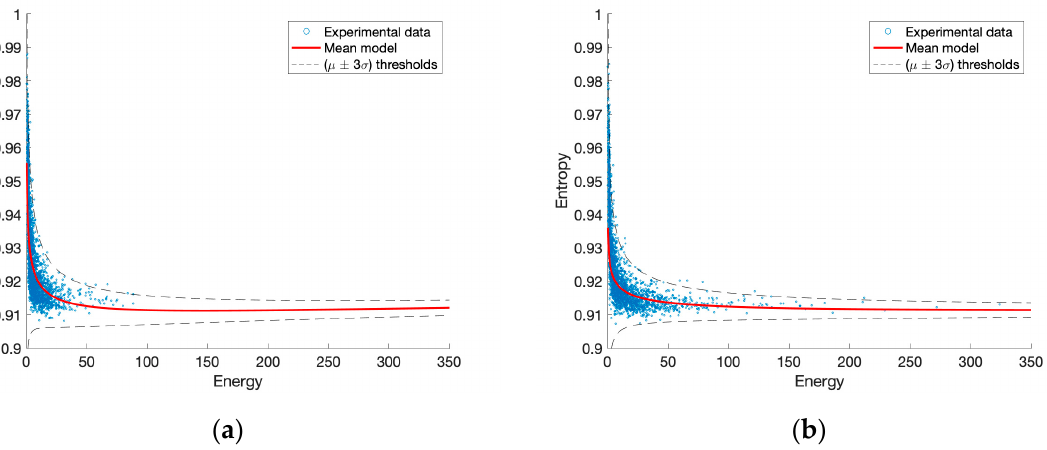
Figure 21. Entropy–energy dispersion, mean model and thresholds for the Colosseum: ( a ) period from 2011 to 2015; ( b ) period from 2015 to 2019.